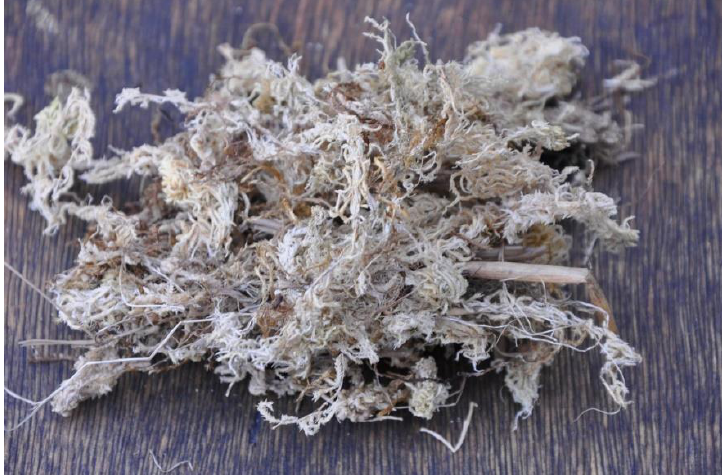
Figure 1. Dry peat moss